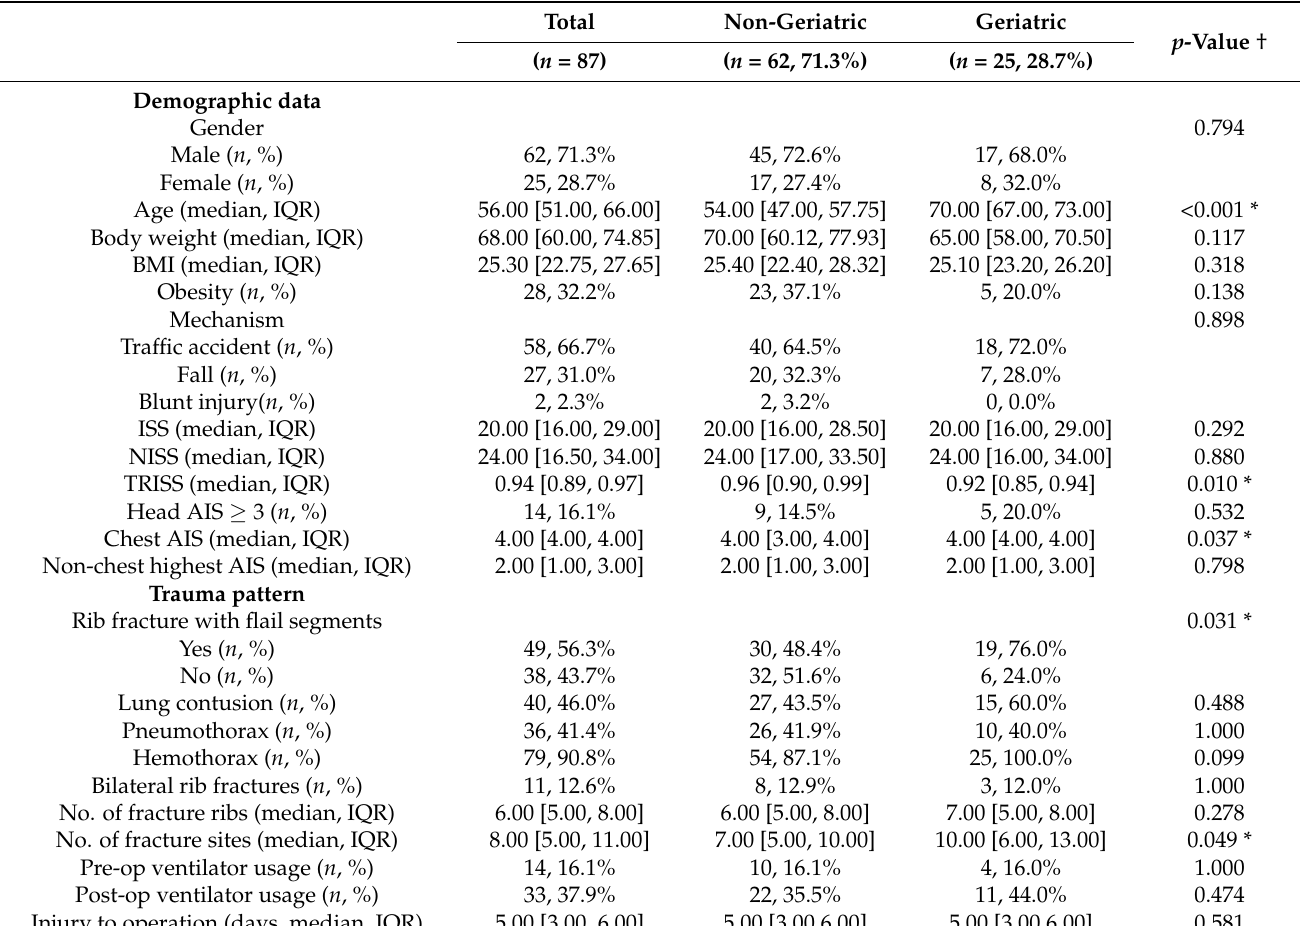
Table 1. The overall demographics and a comparison between the geriatric population and the non-geriatric population ( n =